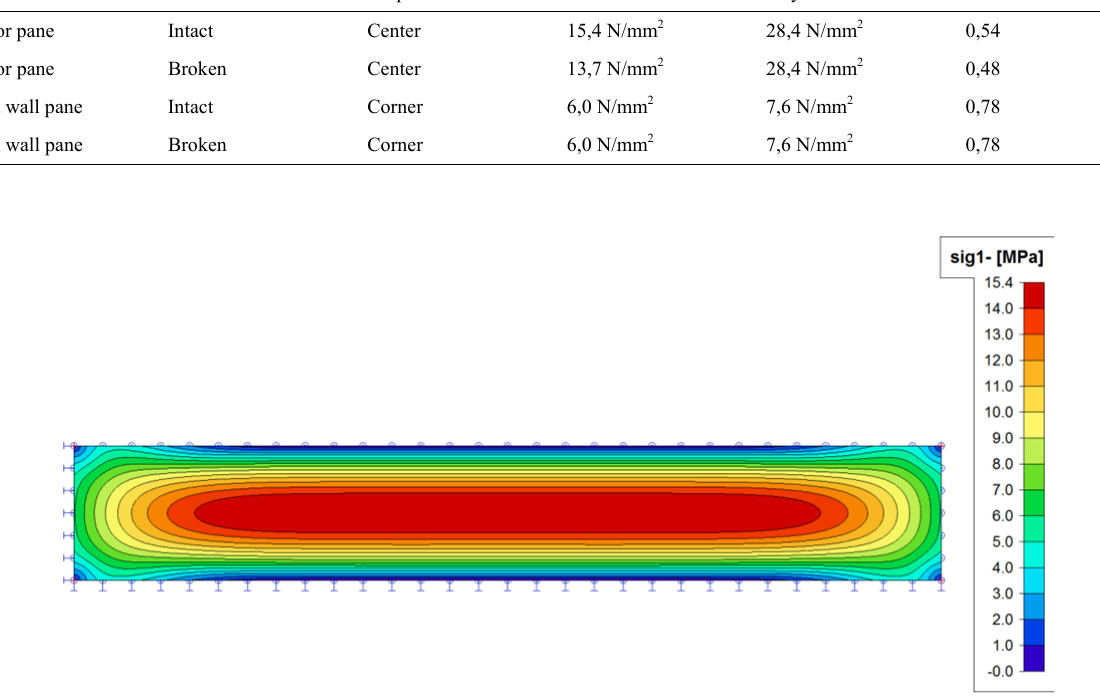
Fig. 8 Principal bending tensile stresses on bottom side of floor pane in N/mm 2 (intact